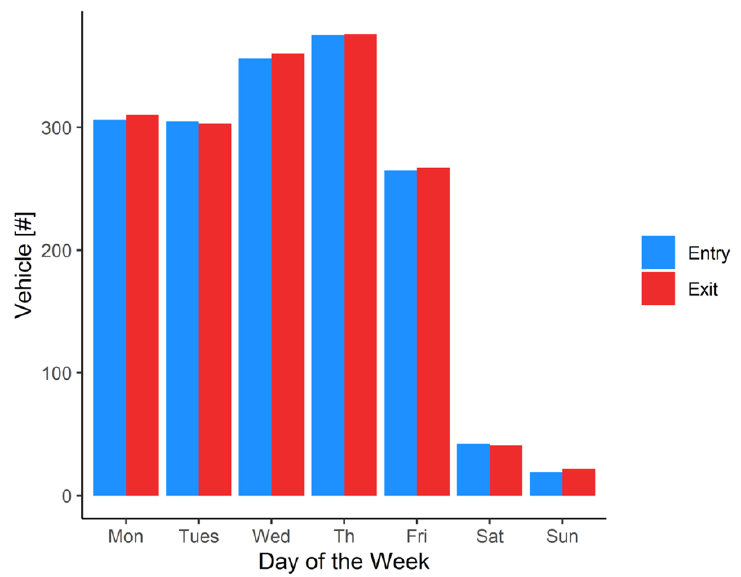
Figure 2. Average entry and exit of number of vehicles per day by day of the week in the parking garage in East bank campus at University of Minnesota. Table 2. Overall correlations among variables in the study.